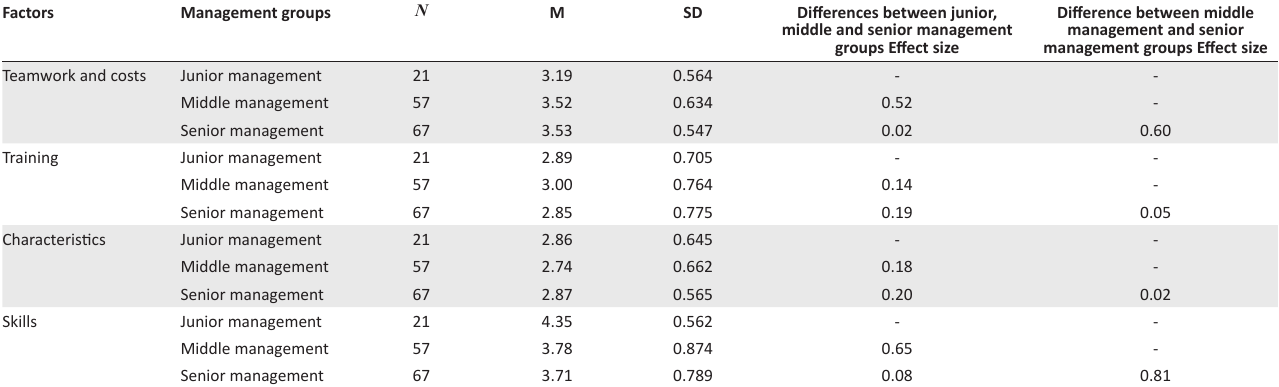
TABLE 6: Comparison of mean scores between management groups.